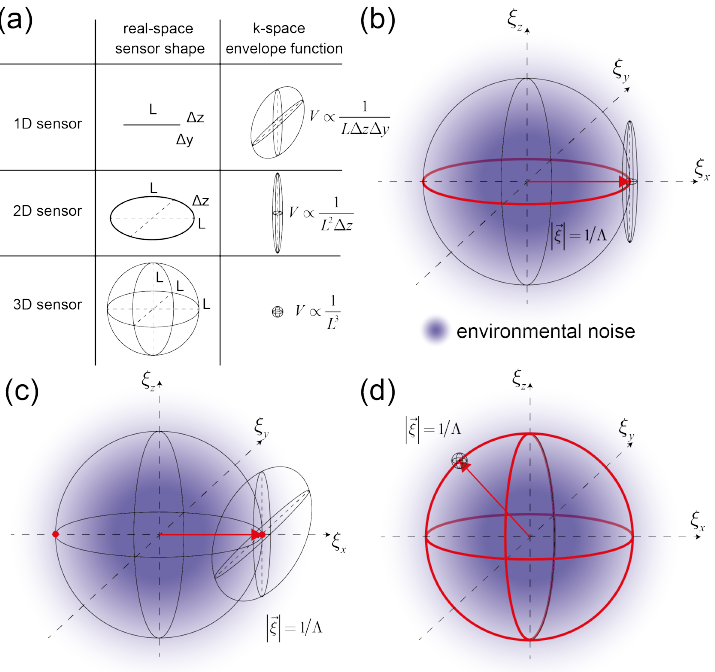
Figure 3. Transfer functions of spatial lock-ins and schematic 1/ ξ (environmental) noise ( a ) Transfer functions of 1D, 2D and 3D sensors. The volume of the envelope function in reciprocal space decreases with increasing dimensionality of the sensor. For a given lock-in frequency, the amount of picked up noise decreases from 1D to 3D sensors. ( b ) 2D sensor transfer functions with equal signal-to-noise (cid:12) (cid:12) (cid:126) ξ (cid:12) (cid:12) ratio and the same lock-in momentum magnitude (cid:12) (cid:12) form a circle in the ξ x , ξ y plane ( c ) 1D sensor transfer functions with equal SNR and the same lock-in momentum magnitude are just two points in reciprocal space. ( d ) 3D sensor transfer functions with the same SNR and same lock-in momentum represent an entire sphere in reciprocal space. This allows for many possible sensor